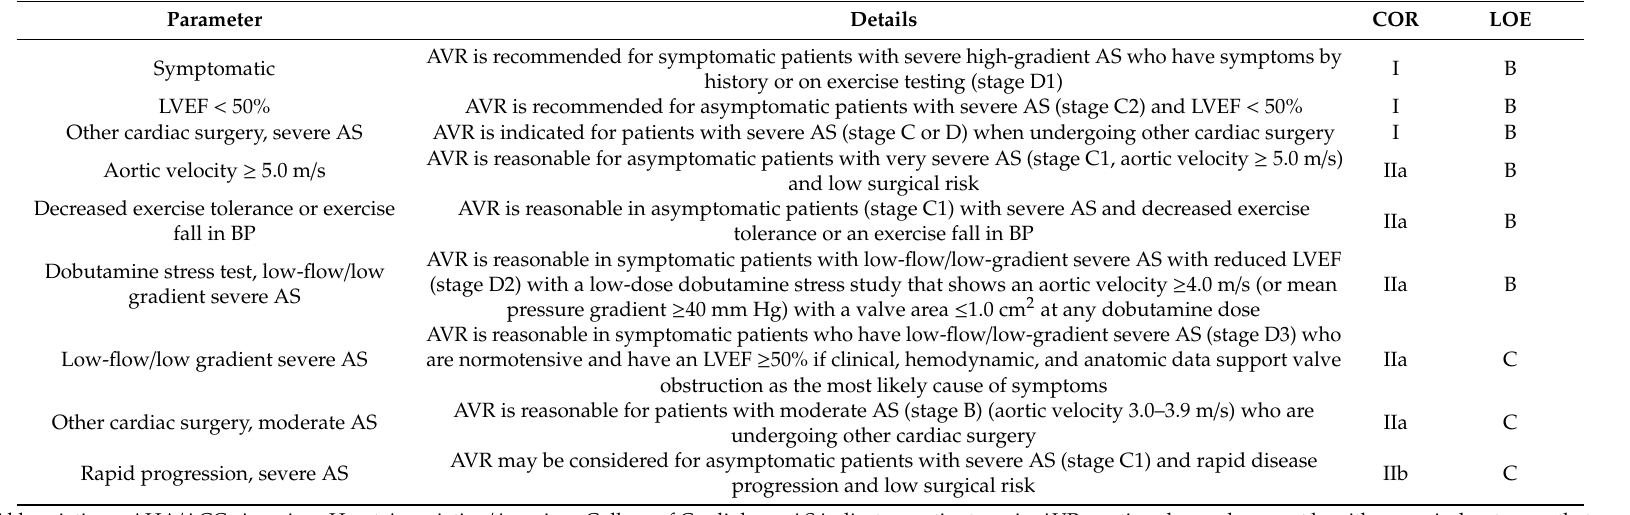
Table 2. Summary of AHA / ACC 2014 guideline recommendations for AS